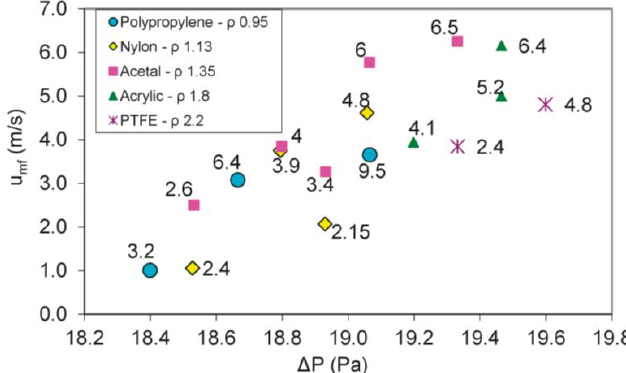
Figure 5. Minimum fluidization velocity vs. pressure drop for different particles. (Density, ρ, in g/cm 3 ; Numbers next to each point is the particle size in mm)